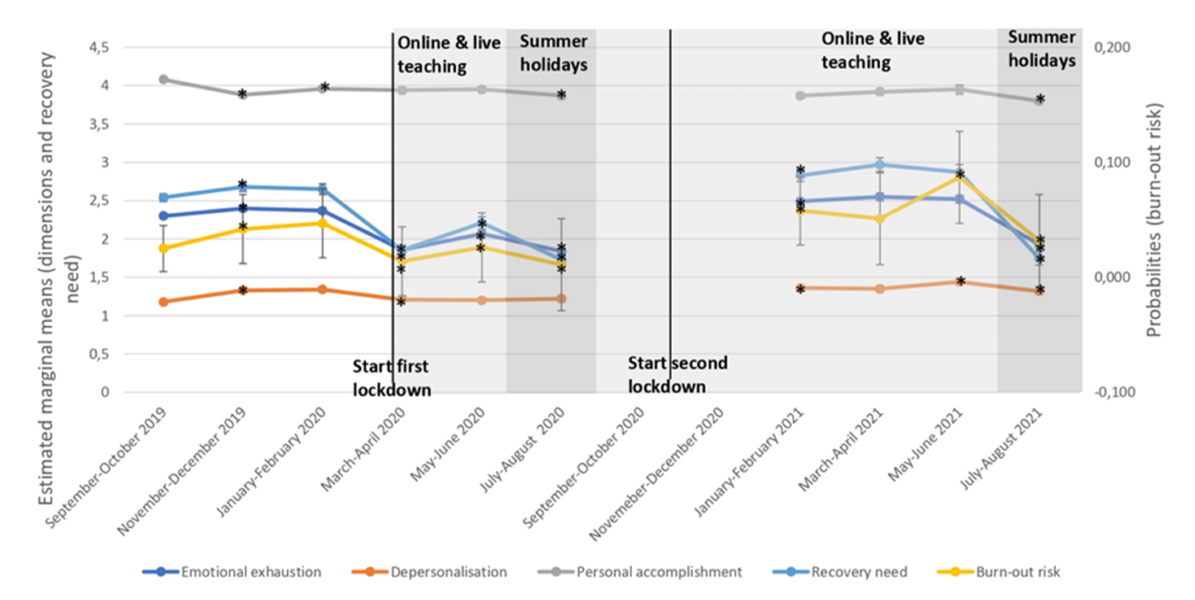
FIGURE3 Changes in burnout risk, burnout dimensions and recovery need over time. *Time point significantly different (p < 0.05) from previous time point.